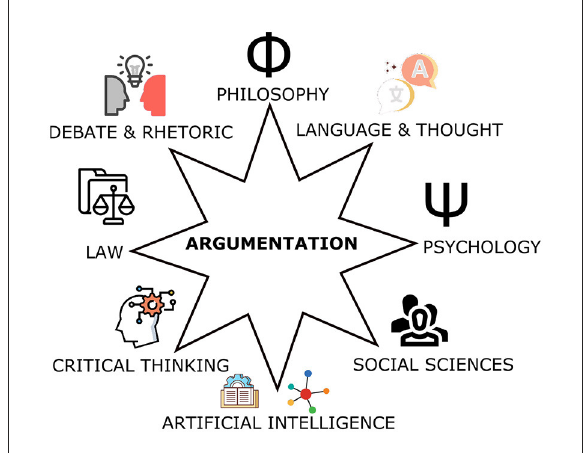
FIGURE2 Overview of disciplines that study